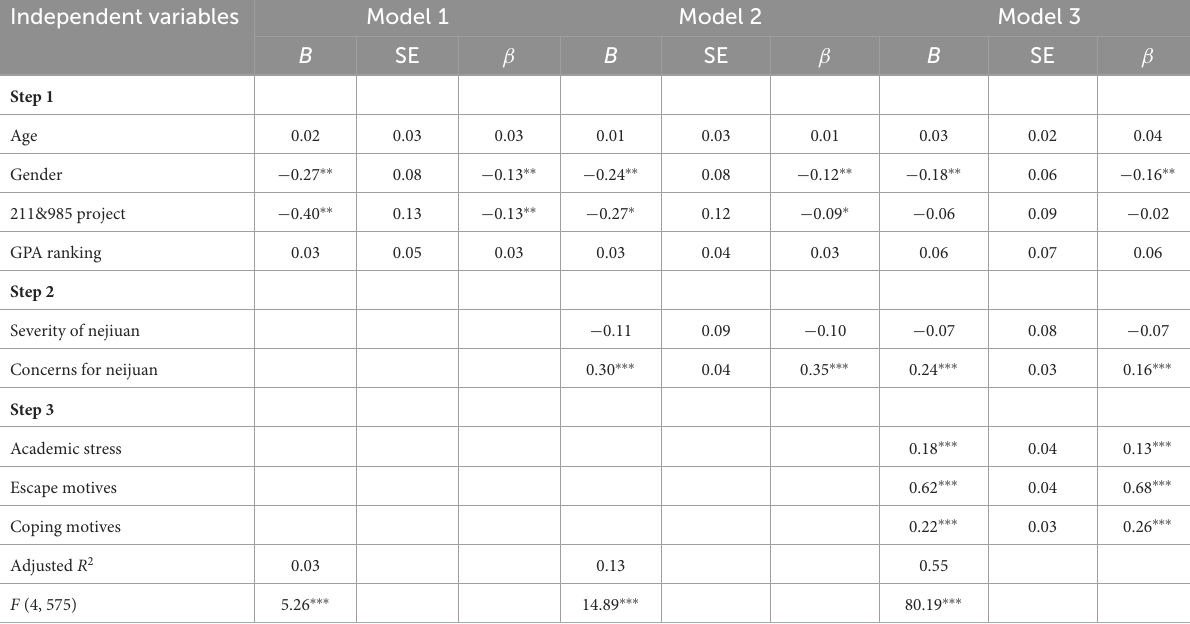
TABLE 7 Hierarchical regression analysis on Internet gaming disorder. Independent